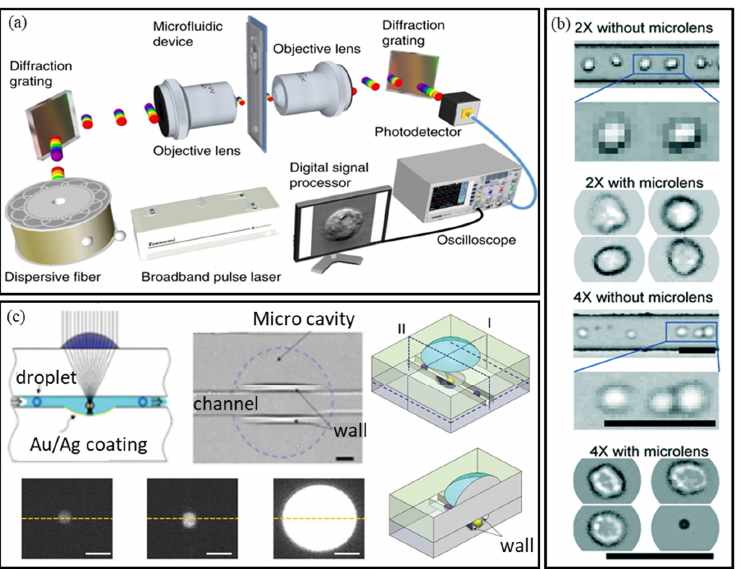
Figure 3. High-throughput cytometry imaging. ( a ) Optofluidic time-stretch microscopy for high- throughput cell imaging. ( b ) Microlens array-incorporated optofluidic chip for high-throughput im- aging of cells. ( c ) Microlens array fabricated with two-photon stereolithography for high-through- put imaging of fluorescent droplets. ( a ) Reprinted with permission from ref [59], Copyright 2018, Nature Publishing Group; ( b ) reprinted with permission from ref [30], Copyright 2018, Royal Soci- ety of Chemistry; ( c ) reprinted with permission from ref [34], Copyright 2018, Wiley-VCH GmbH.